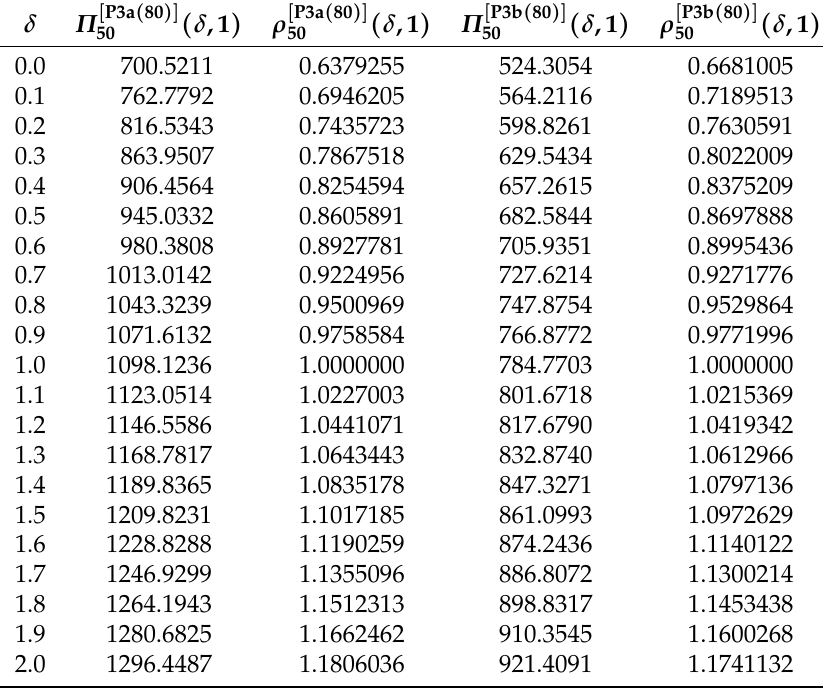
Table 11. Products P3a, P3b (insurance packages); x = 50, C = 1000, b (cid:48) = 50, b (cid:48)(cid:48) =